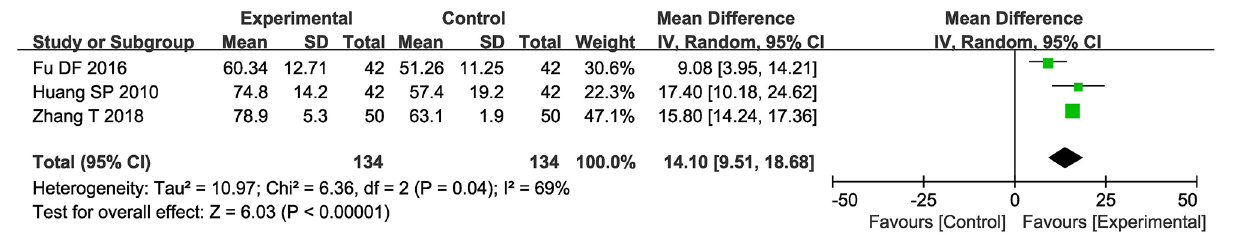
FIGURE 5 | Forest plot of the comparison of Barthel Index (BI) score between the experimental and control group. Control group, conventional treatments alone group; Experimental group, conventional treatments and GDI combined group. GDI, Ginkgo leaf extract and dipyridamole injection. The random effects meta- analysis model (Inverse Variance method) was